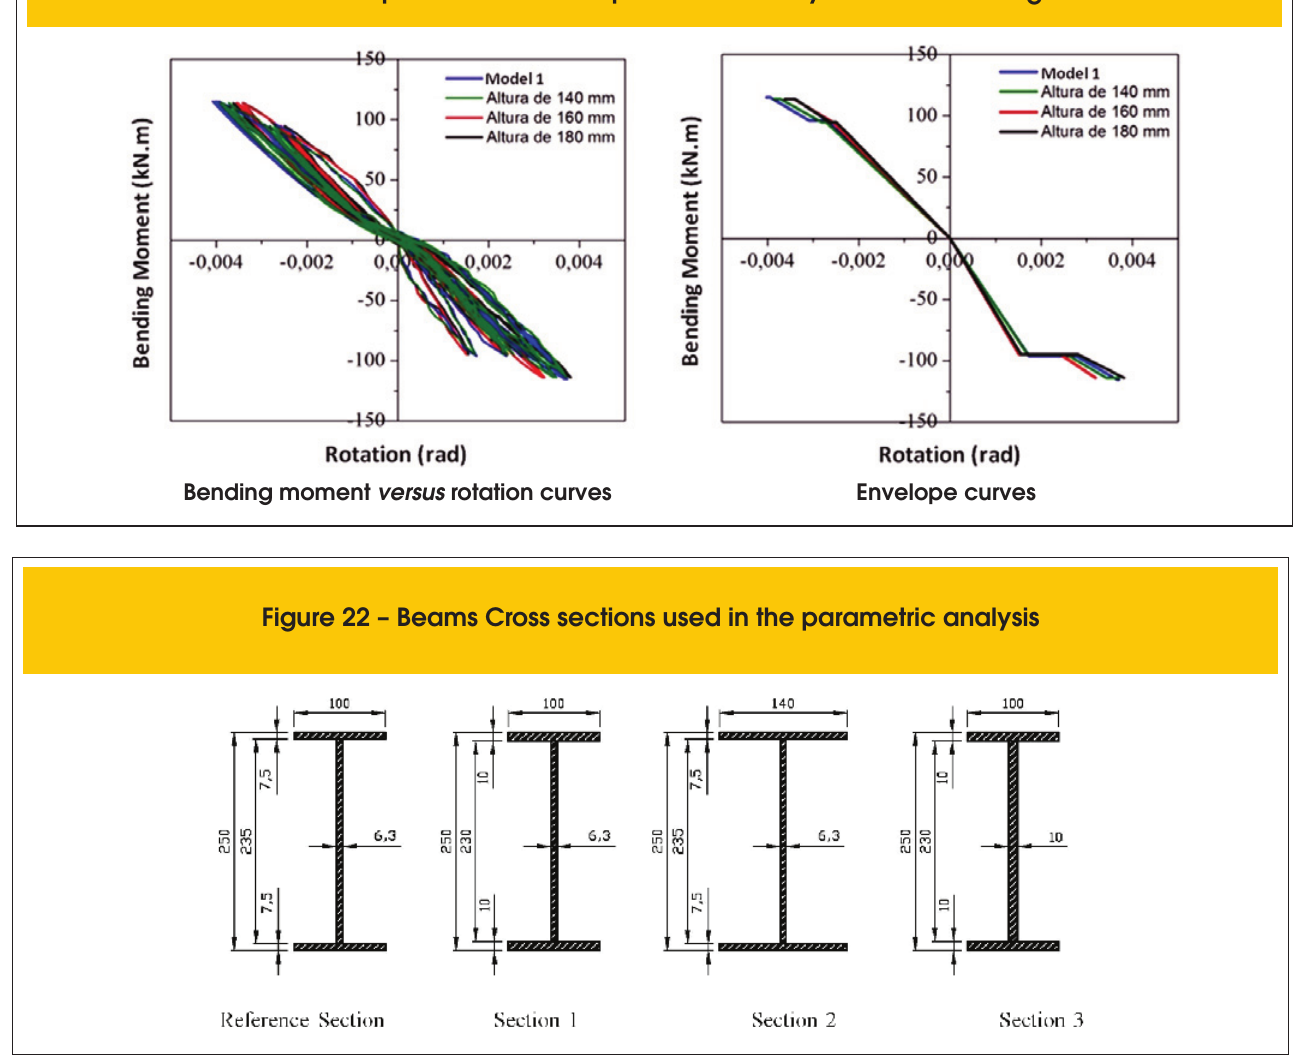
Figure 21 – Comparison of bending moment versus rotation curves and envelope curves used for parametric analysis of the slab height